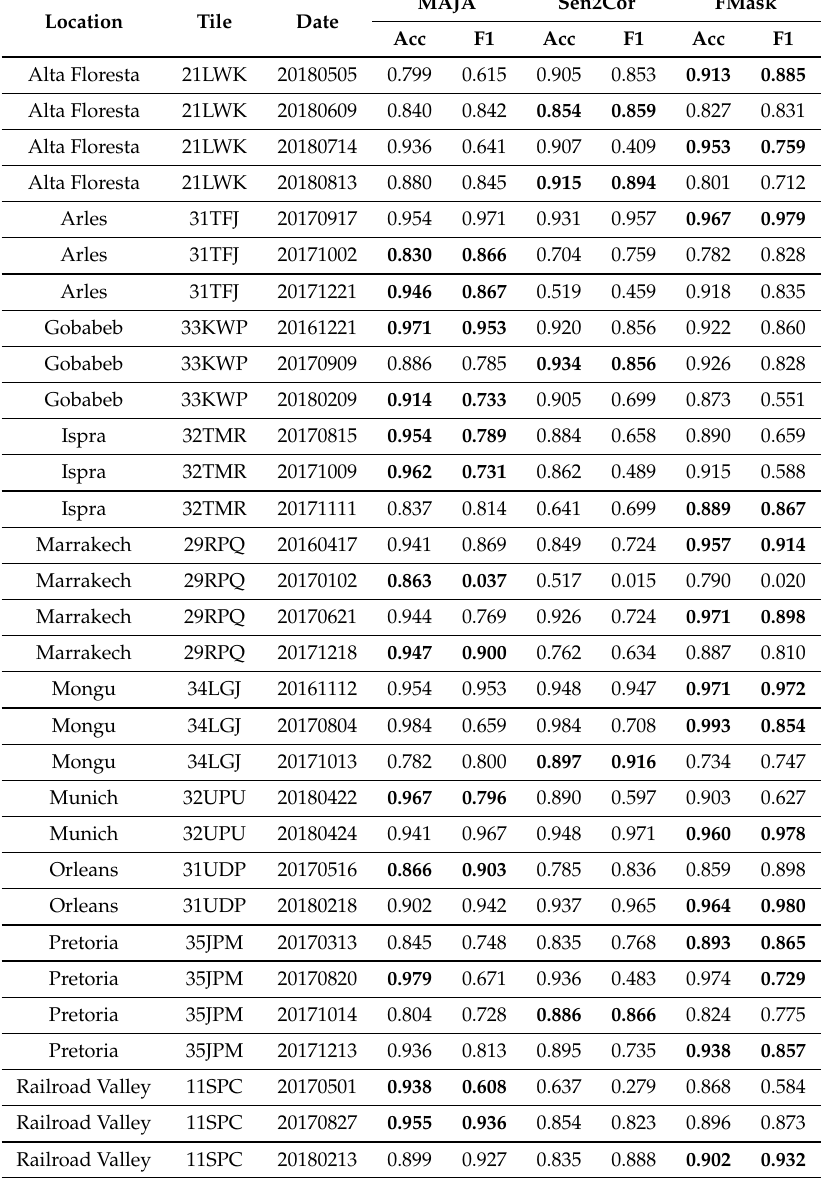
Table 8. Accuracy and F1-score for each scene, with the original masks for MAJA and the dilated masks for ALCD, Sen2Cor, and FMask. In bold, the best metrics for each scene. Dates are written with format YYYYMMDD to save